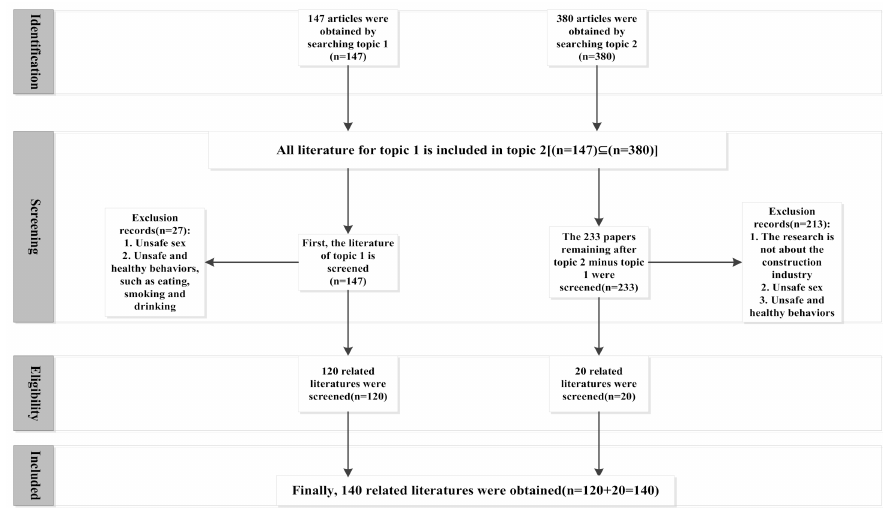
Figure 1. Flowchart of the systematic review process (PRISMA flow diagram).